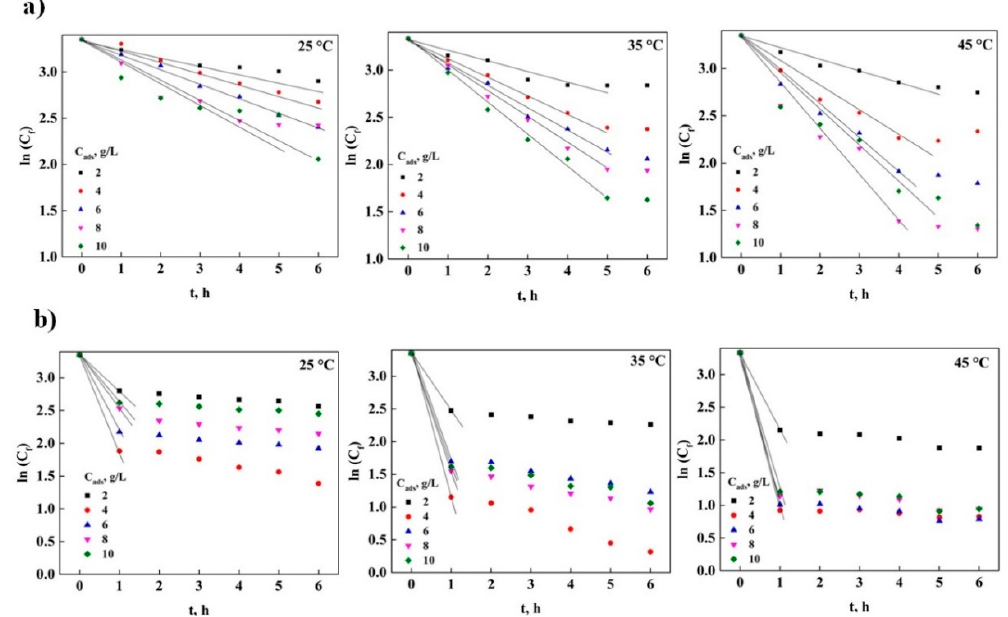
Figure 4. External mass transfer analysis at different temperatures: ( a ) GAC and ( b ) PAC.